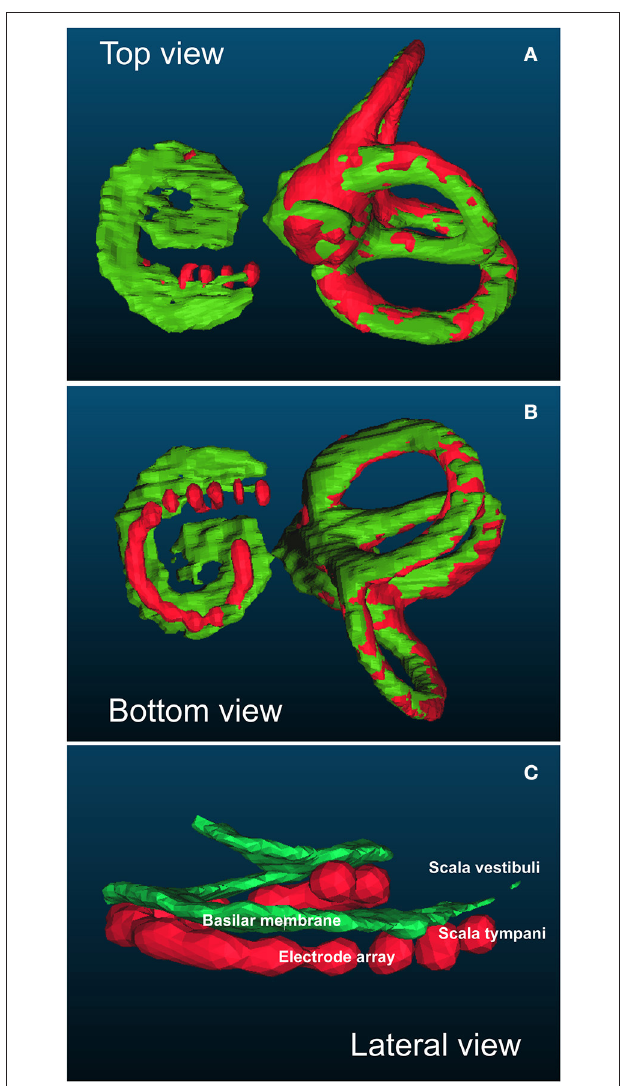
FIGURE 1 | Example of top (A) , bottom (B), and lateral (C) views of the basilar membrane to assess the position of each electrode in relation to the basilar membrane. The positions of the basilar membrane and semicircular canals were obtained from the pre-implantation computed tomography (CT) (in green). The positions of the electrode array and semicircular canals were obtained from the post-implantation CT (in red). Both models were automatically merged according to the position of the semicircular canals that were not modified by the artefact of the electrode array. In this example, the electrode array was below the basilar membrane and consequently fully inserted into the scala tympani (no array translocation).